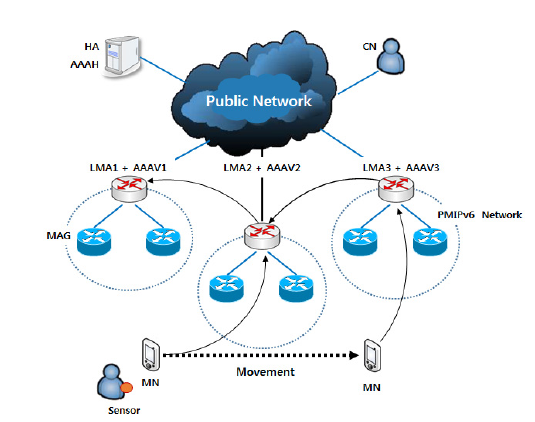
Figure 3. Forwarding scheme between different LMA.